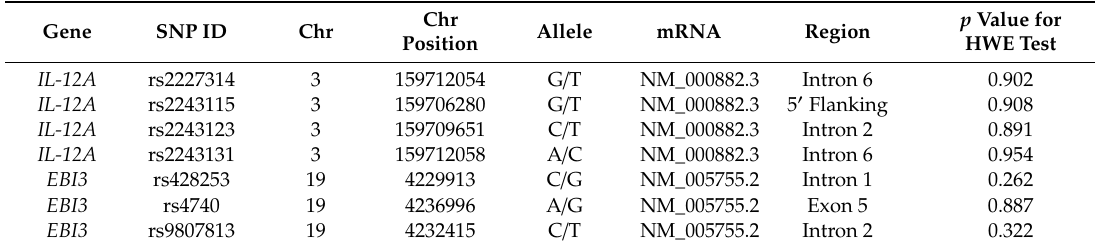
Table 1. SNPs genotyped in IL-12A and EBI3 genes.